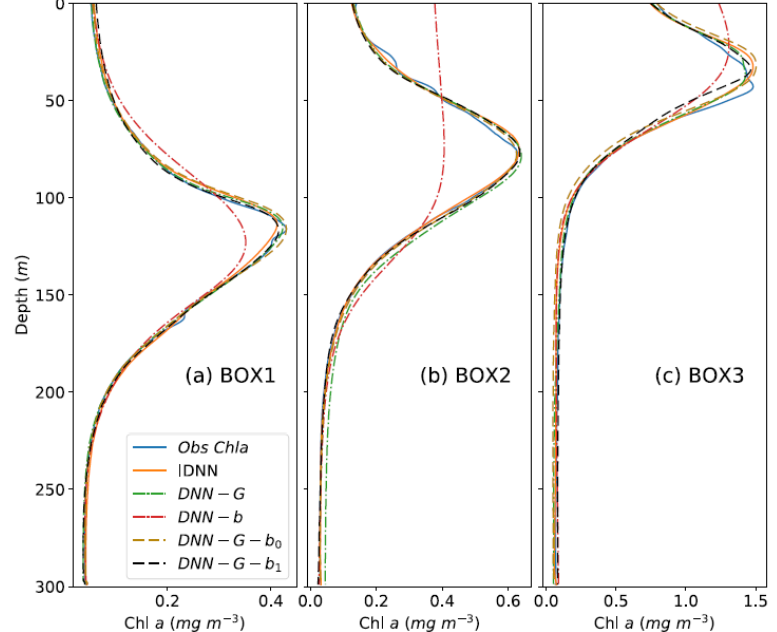
Figure 7. Aggregated chlorophyll vertical profiles from the test set in different experiments in BOXes 1 – 3 ( a–c